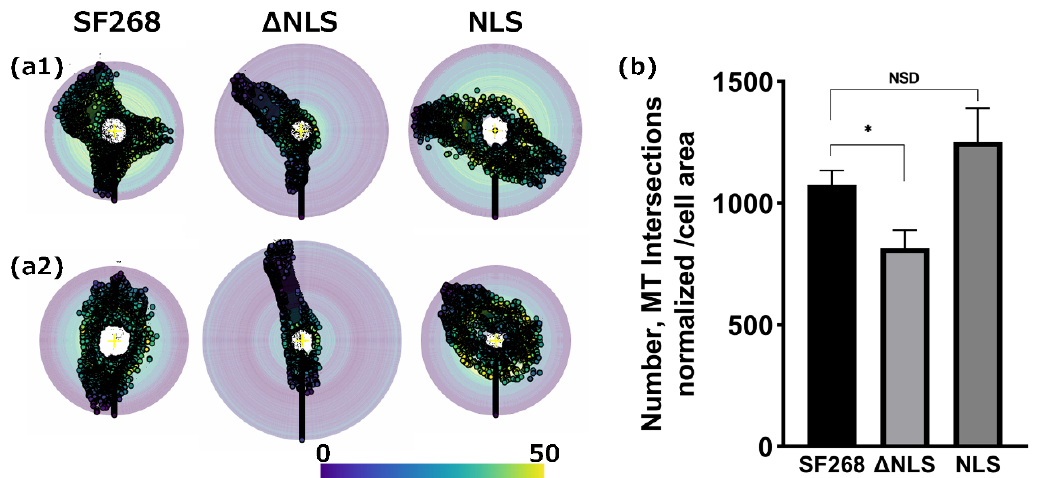
Figure 2. Knockdown of NLS neurofibromin reduces intracellular microtubule (MT) intersections. Sholl analysis on confocal images, captured after di ff erent fixations, ( a1 ) DSP crosslinking and PFA fixation or ( a2 ) methanol fixation, revealed that SF268 and NLS-SF268 cells showed high numbers (yellow hues) of MT intersections around the nucleus and the MTOC / centrosome area which gradually declined towards the cell periphery (yellow to light blue to purple hues), whereas ∆ NLS-SF268 cells displayed lower numbers of MT intersections and almost uniform distribution along the nucleus-cortex radius. ( b ) Quantification of MT intersections in each genetic background, normalized per cell area. Bracketed bars represent the means and standard errors of measurements in 20 cells per cell line from each of 3 separate experiments; *, p < 0.05; NSD, no significant difference.